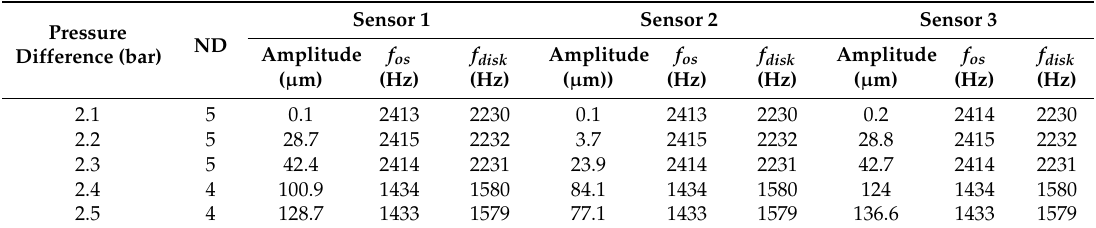
Table 4. Results for the first prototype at 1.5 × RPM nominal .